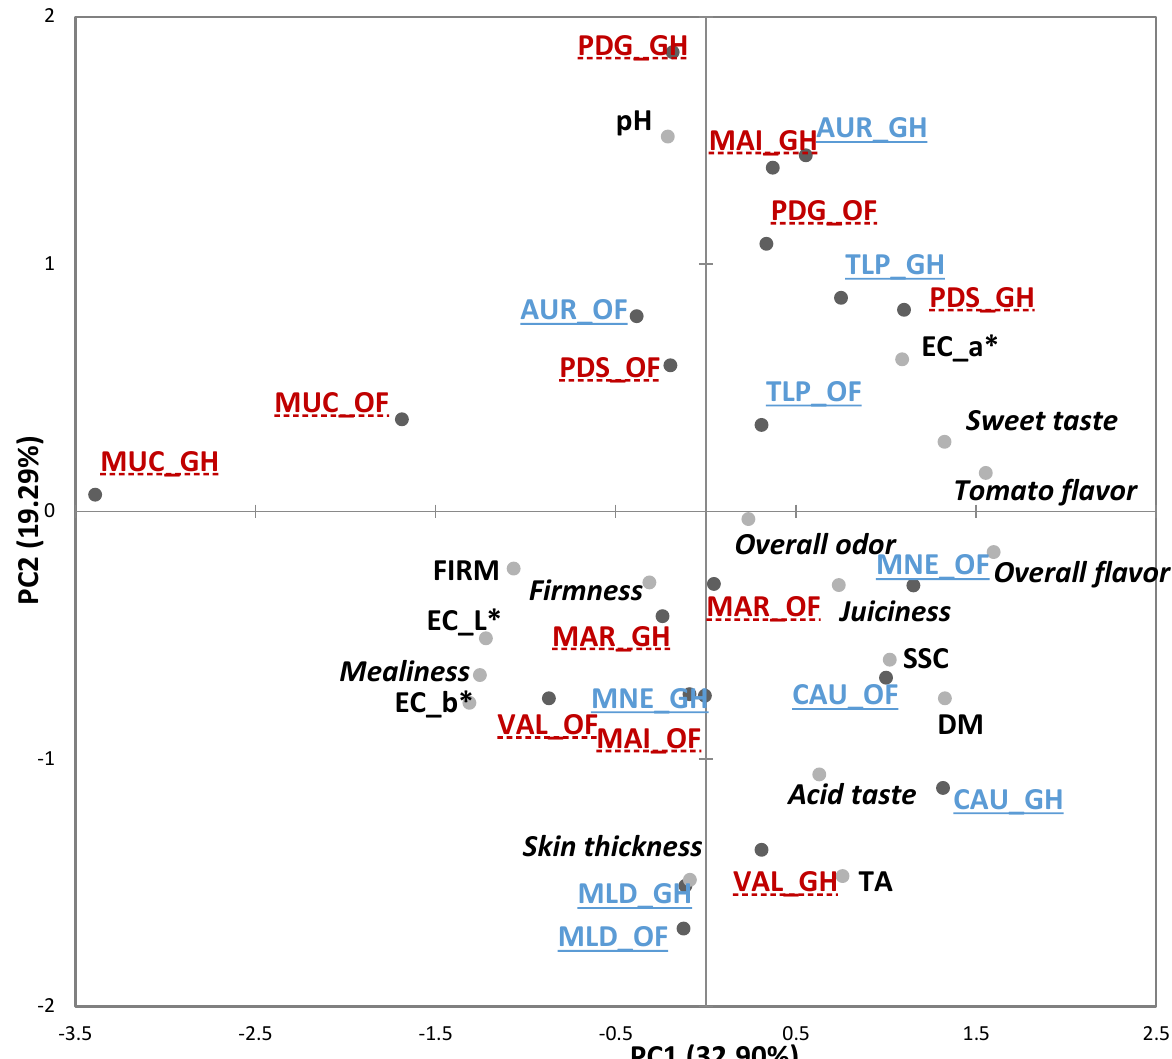
Figure 2. Principal component analysis (PCA) Bi-plot of the sensory and physicochemical parameters of the 11 tomato genotypes grown in Greenhouse (GH) and Open Field (OF) in Spain. Sensory descriptors are indicated in italics . Modern varieties are in blue, underlined with solid lines; Traditional varieties are in red, underlined with dashed lines. FIRM = firmness (instrumental), SSC = soluble solids content, TA = titratable acidity, DM = dry matter. Product codes are listed in Table